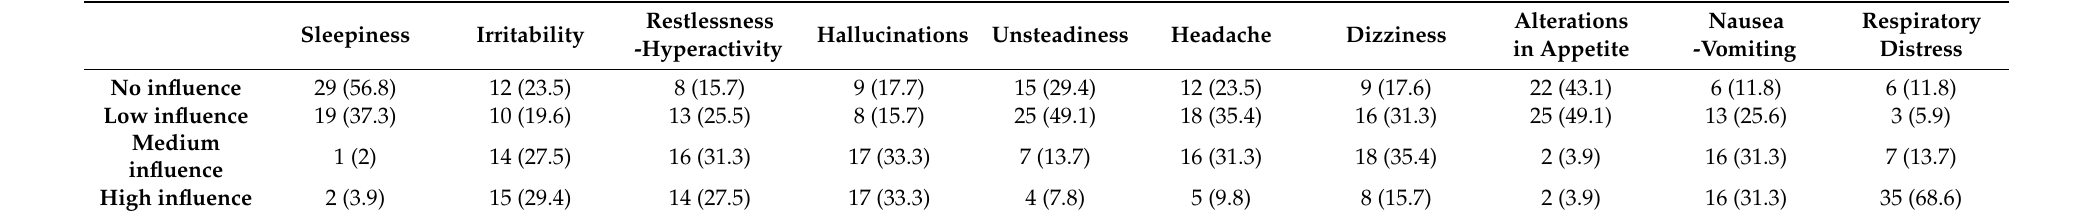
Table 3. The impact of adverse effects in reducing nurses’ satisfaction on procedural sedation ( n , %). Sleepiness Irritability